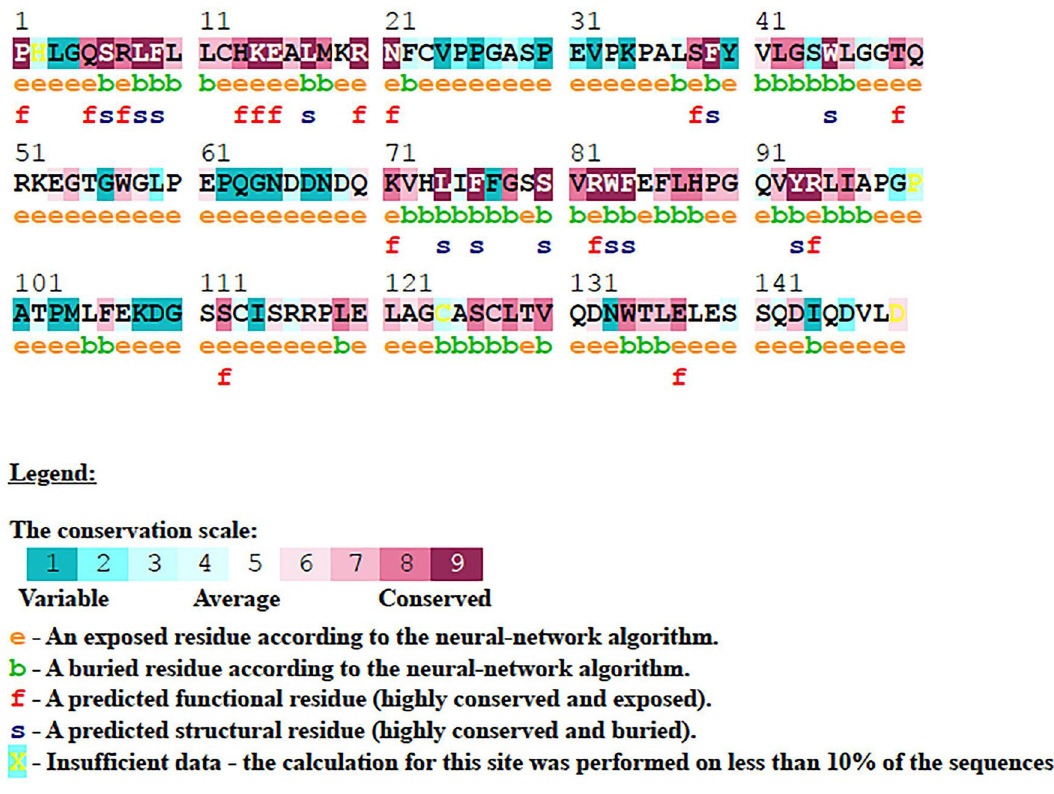
Figure 7. Sequence Conservation analysis of the C-terminal OB-fold region of CTC1 protein using ConSurf